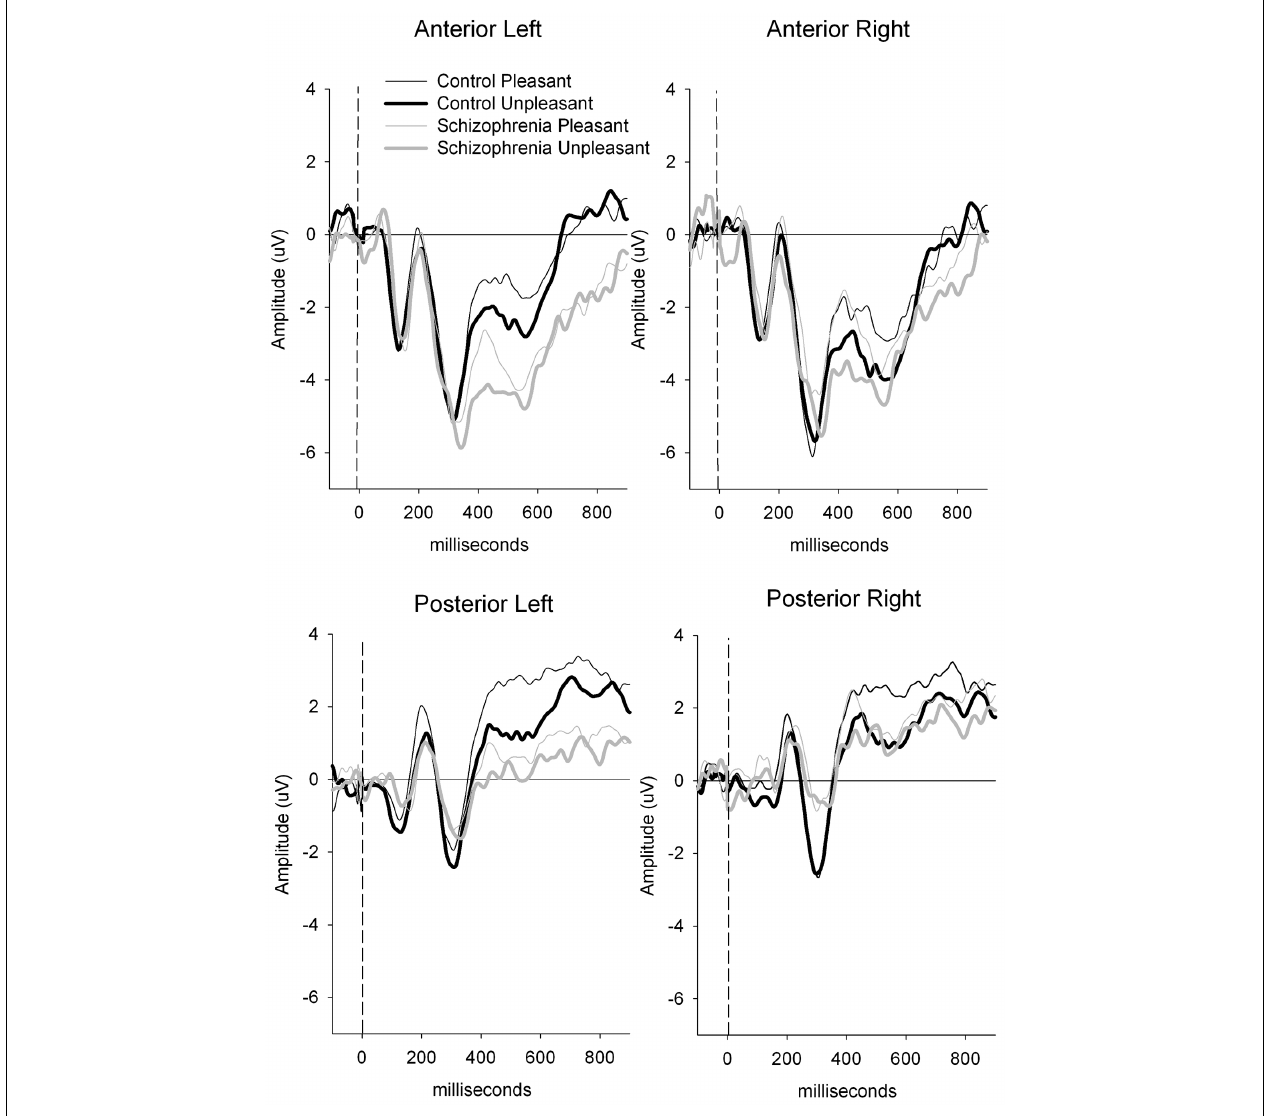
FIGURE 1 | Clinical group comparison between anterior and posterior P300 amplitude. P300 amplitude is generally smaller in schizophrenic patients compare to the control group in all conditions, but differences between pleasant and unpleasant are larger over anterior region in this group.